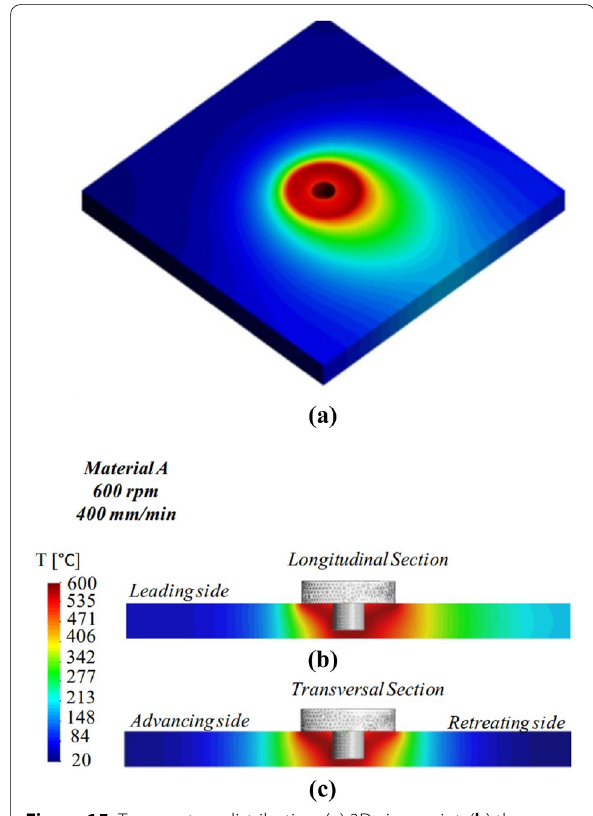
Figure 15 Temperature distribution: ( a ) 3D view point, ( b ) the longitudinal direction ( c ) the transversal direction [113]